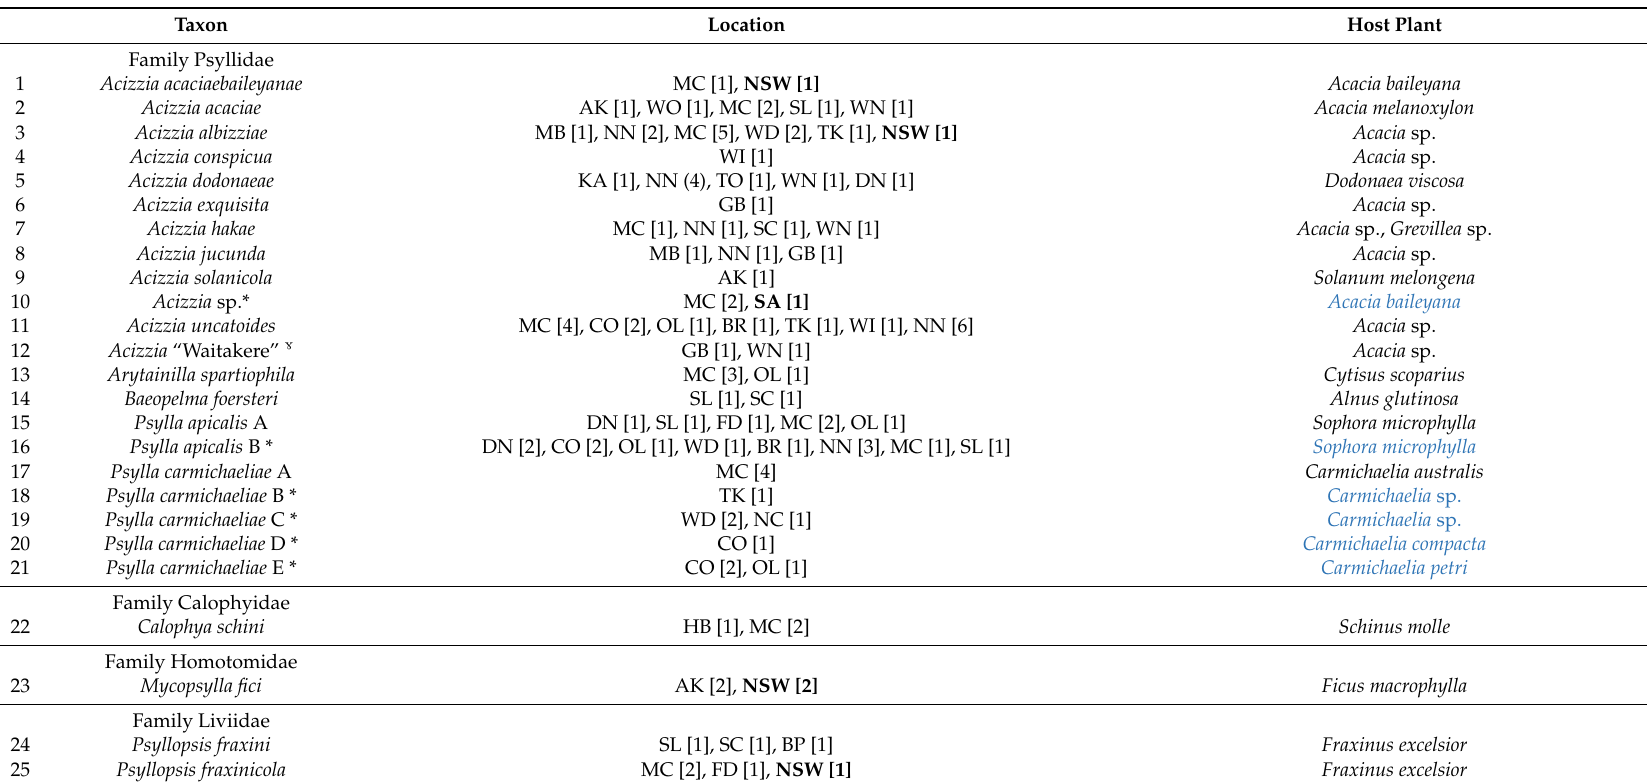
Table 2. New Zealand psyllid taxa delimited using their morphology, plant association, and COI sequence divergence of >3%. Newly recorded taxa (*), not formally described but previously known taxa ( È ) and taxa not identified to the species level (?) are reported. New Zealand locations are based on Crosby’s work [31]; Australian locations (in bold) are New South Wales (NSW), South Australia (SA), and Victoria (VIC). The number of populations from each region is reported in parentheses. The host plants are differentiated between previously known (black), possible new host plants (blue) and uncertain associations